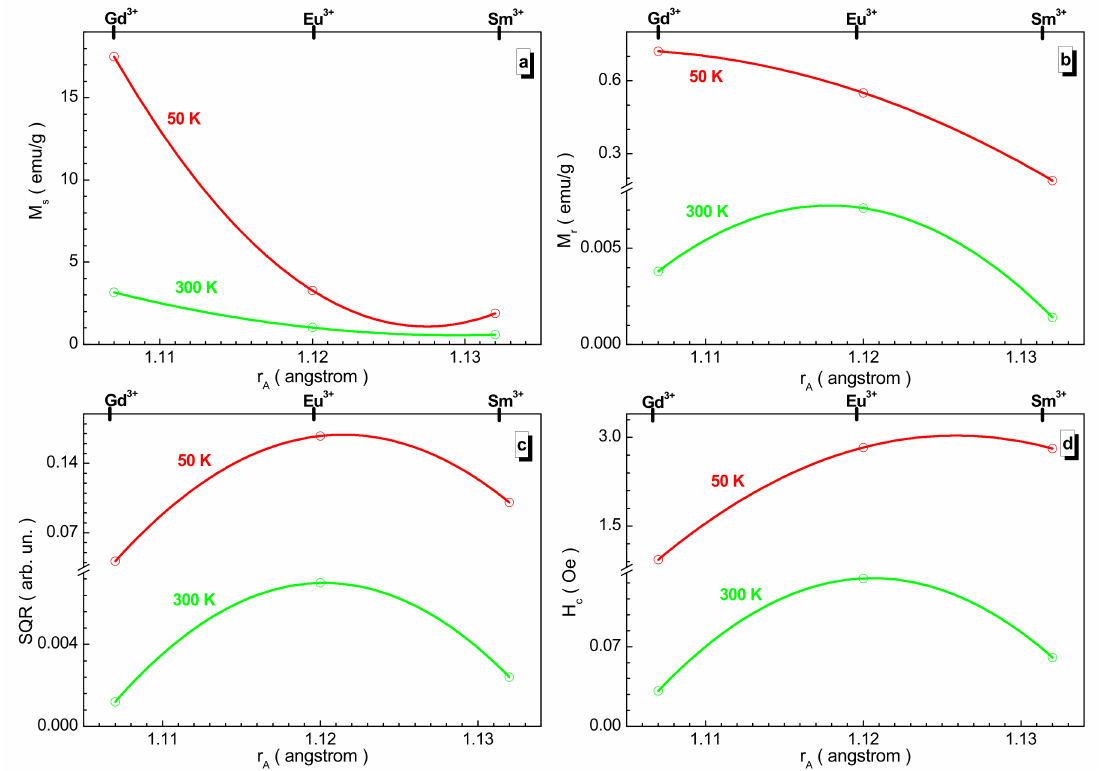
Figure 6. Dependence of the M s spontaneous magnetization ( a ), M r residual magnetization ( b ), SQR = M r /M s squareness of the loop ( c ), and H c coercive force ( d ) vs. A-site cation radius size at 50 K (red circle and line) and 300 K (green circle and line) for the obtained samples. The solid line is the second-order polynomial interpolation and it is an eye